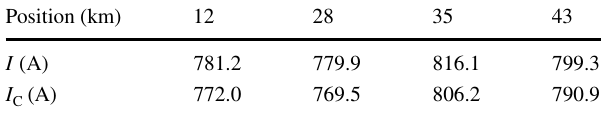
Fig. 12 Comparison of traction network voltage